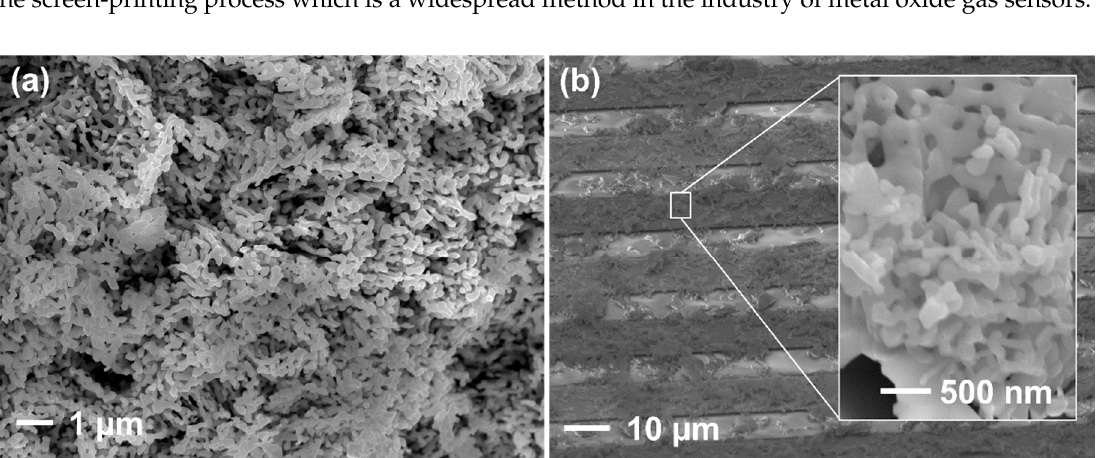
Figure 2. ( a ) Scanning electron microscope (SEM) image of as-prepared powder cross-section of gas